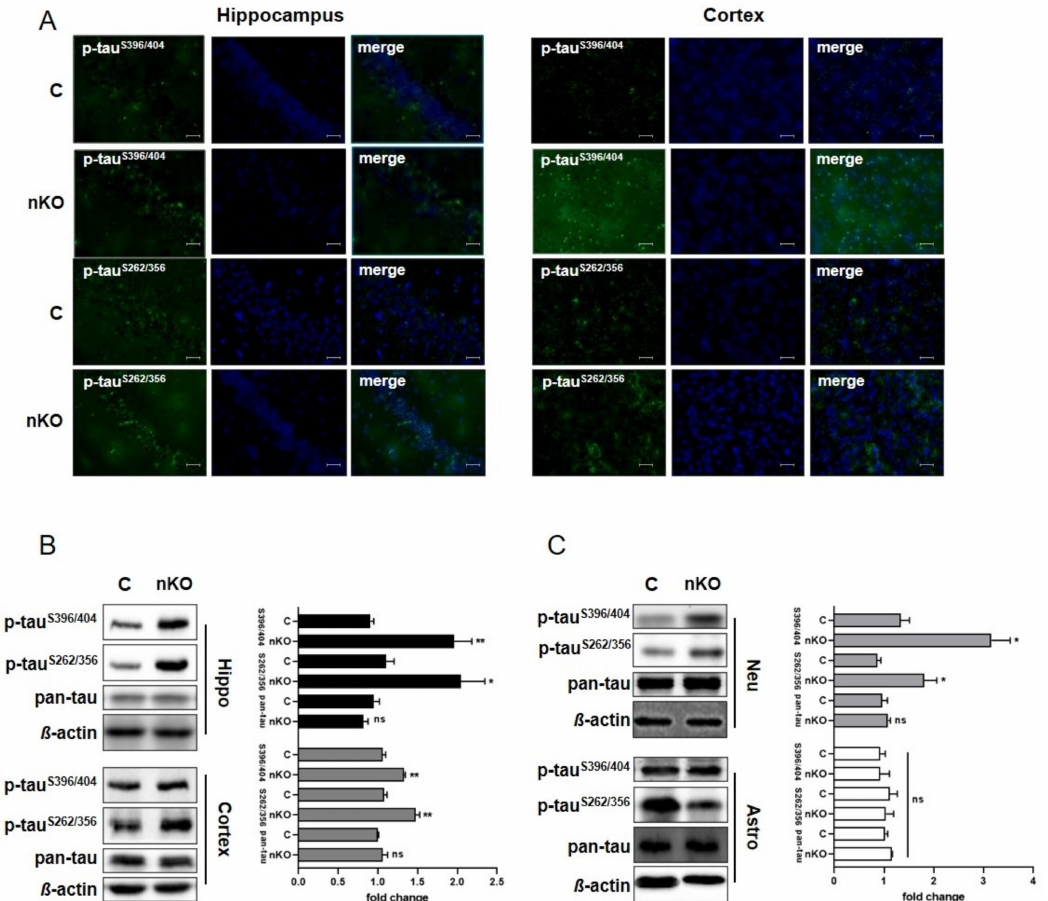
Figure 1. SGPL1 deficiency results in tau hyperphosphorylation in the brain. ( A ) Representative images of hippocampal and cortical slices stained for phospho-tau S396 / 404 , phospho-tau S262 / 356 , and DAPI from control ( C ) and SGPL1 fl / fl / Nes (nKO) mice. Scale bar: 200 µ m. ( B , C ) Protein quantification of phospho-tau S396 / 404 , phospho-tau S262 / 356 , and total tau (pan-tau) in the hippocampus (Hippo, black), cortex (dark grey), neurons (Neu, light grey) and astrocytes (Astro, white) in control ( C ) and SGPL1 fl / fl / Nes (nKO) mice. Bars mean +/ − S.E.M, Student’s t -test with false discovery rate